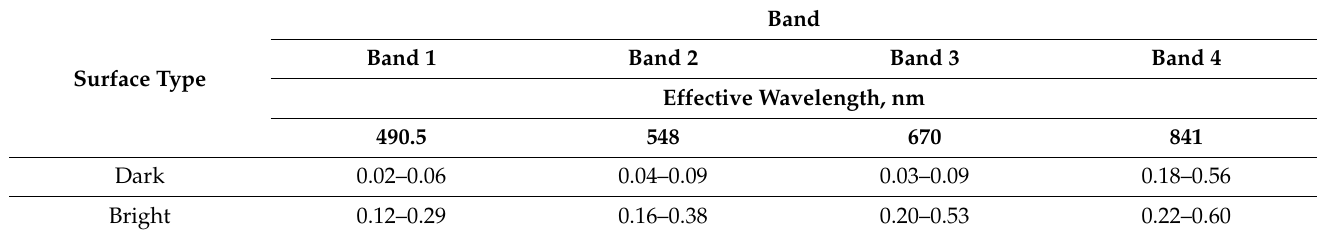
Table 3. The reflectance ranges of dark and bright surfaces in the MZ spectral